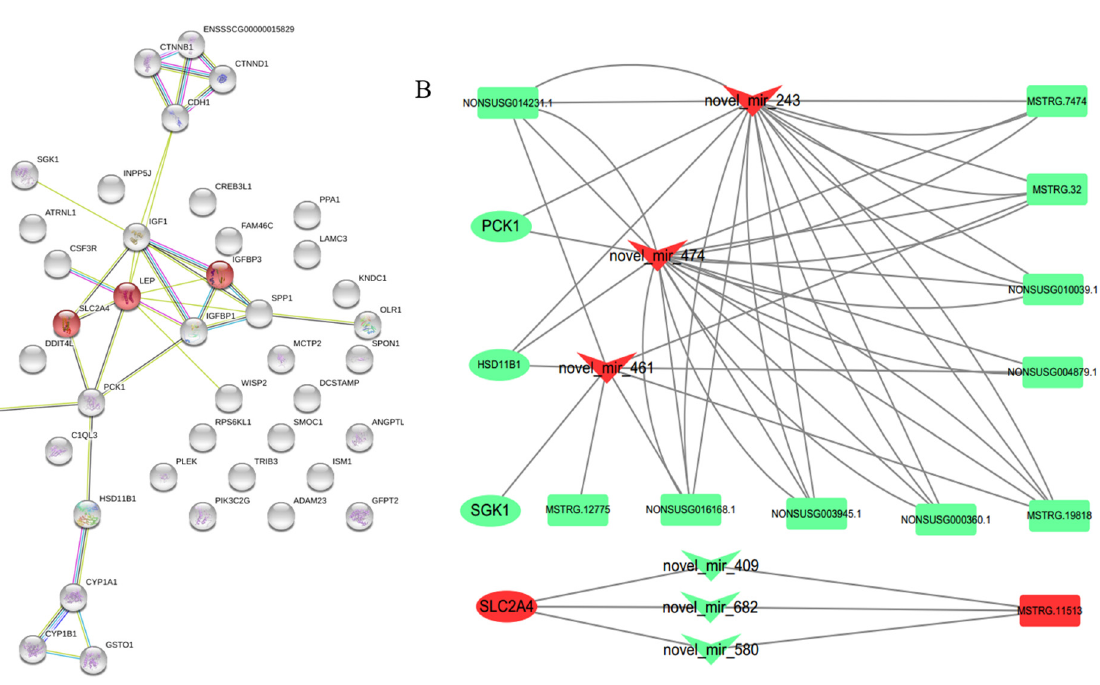
Figure 5. ( A ). Some of the differentially expressed genes were analyzed by protein interactions with STRING. ( B ). LncRNAs regulate the ceRNA network of related genes through miRNAs. Circle indi- cates DE mRNAs, rectangle indicates DE lncRNAs, V shape indicates DE